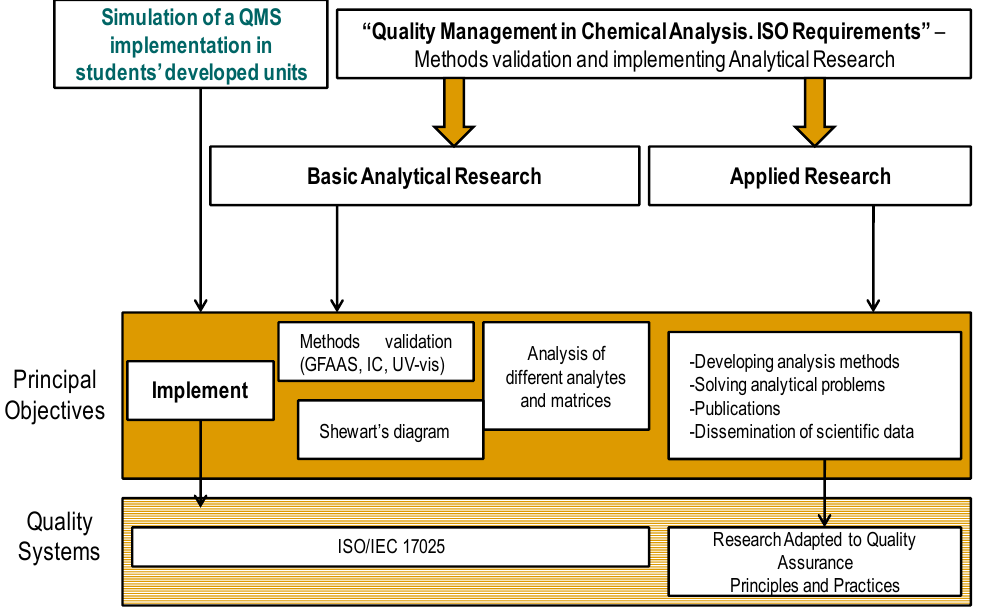
Figure 2. The strategy for practice within the “Quality management in chemical analysis: ISO requirements” course in the academic curriculum of the “Alexandru Ioan Cuza” University of